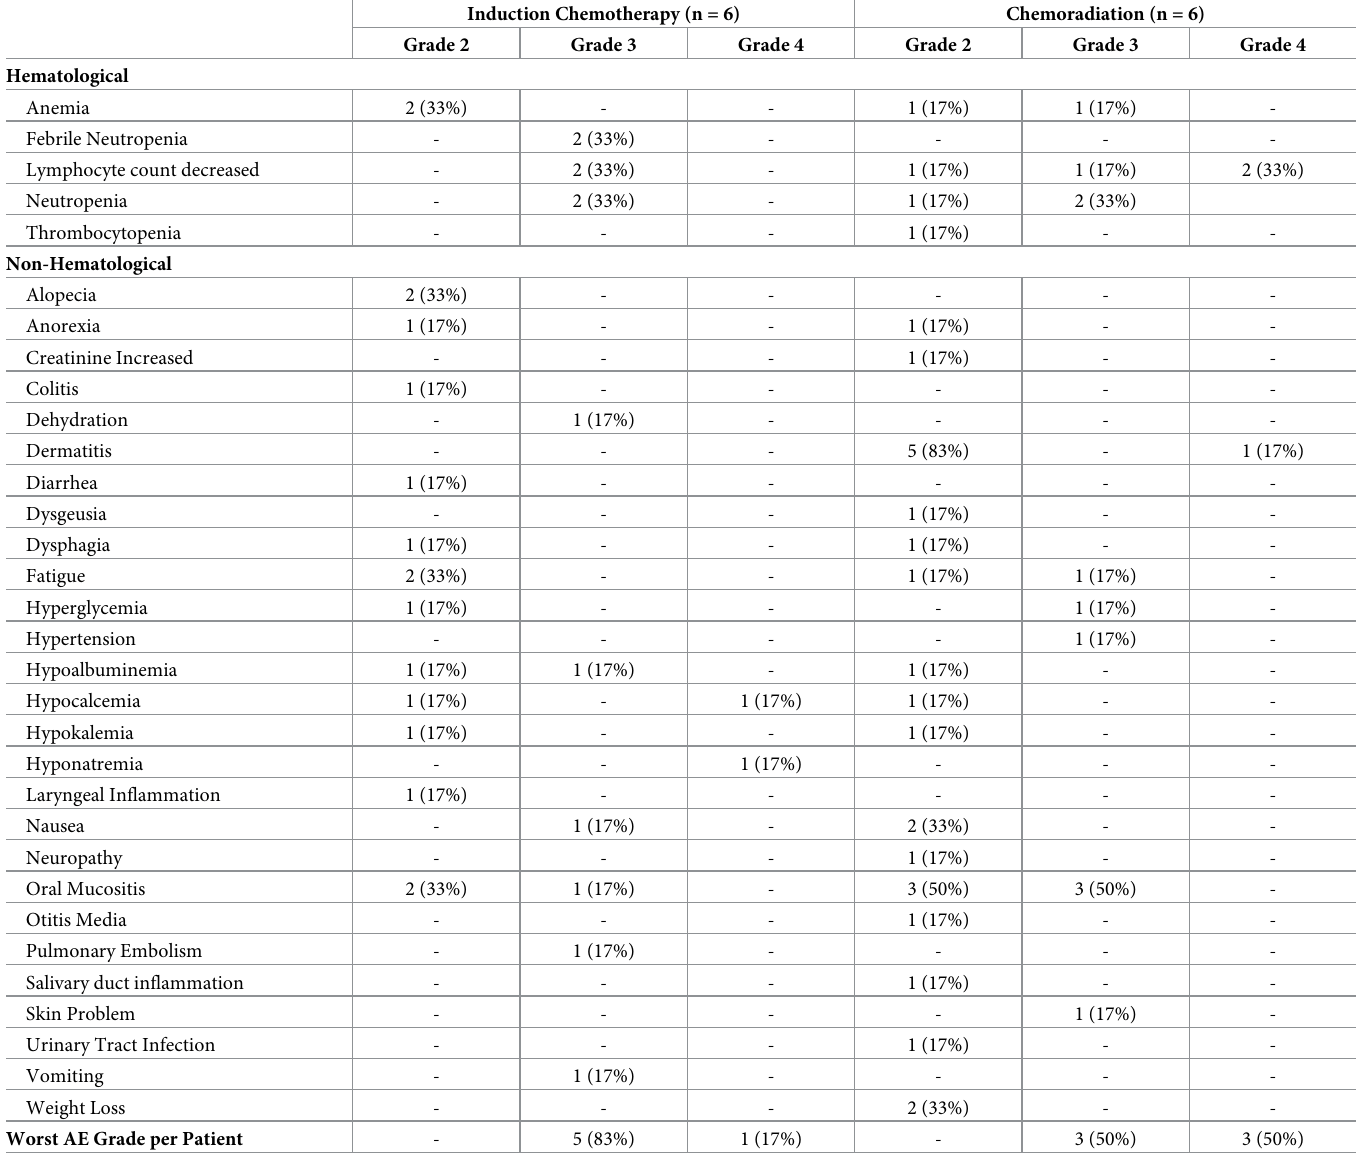
Table 4. Adverse events of M1 cohort, worst grade per patient for each